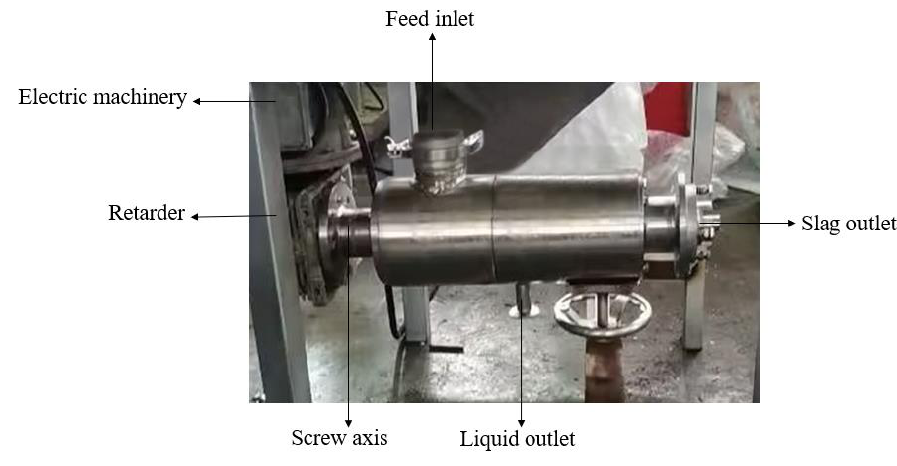
Figure 3. Test device of screw press .